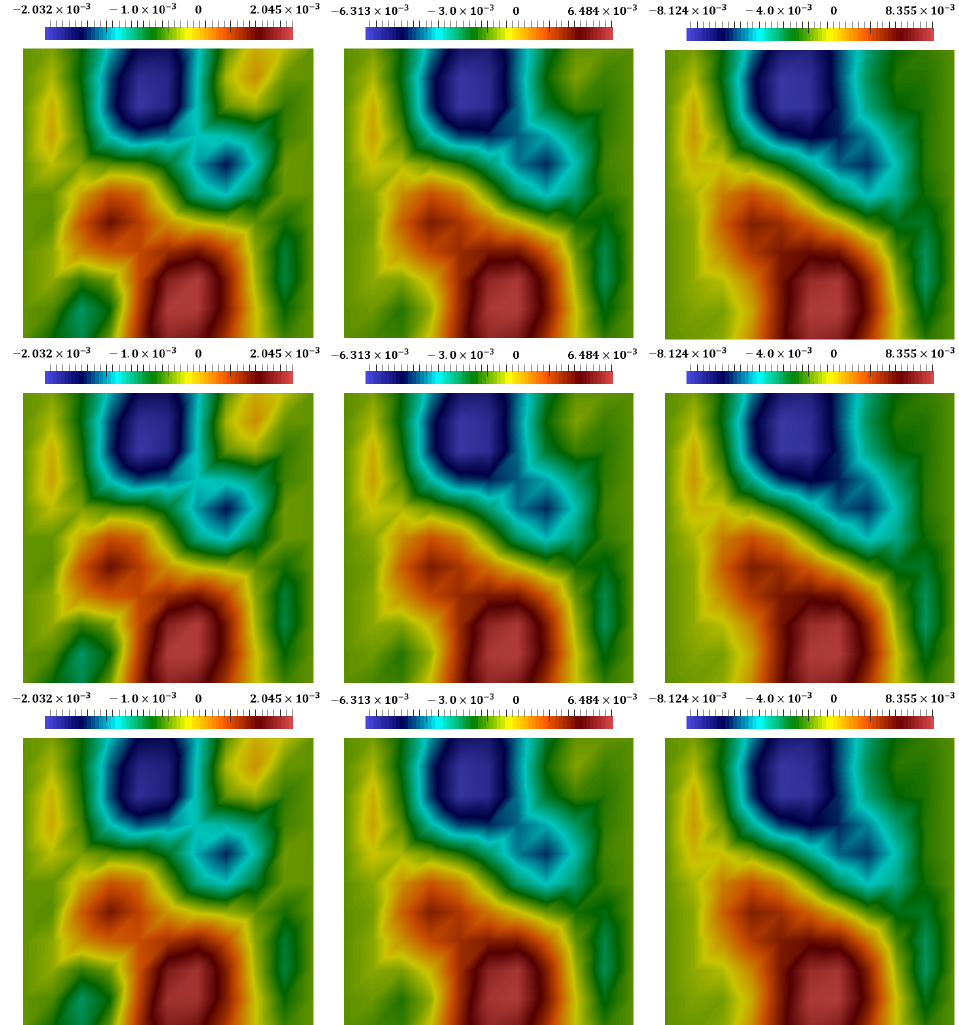
Figure 7. Distribution of displacement in x 1 direction at different times, t m with m = 0.4,0.8,1 (from left to right ). ( The first row ): the coupled explicit–implicit solution. ( The second row ): the split explicit–implicit solution. ( The third row ): the proposed approach’s